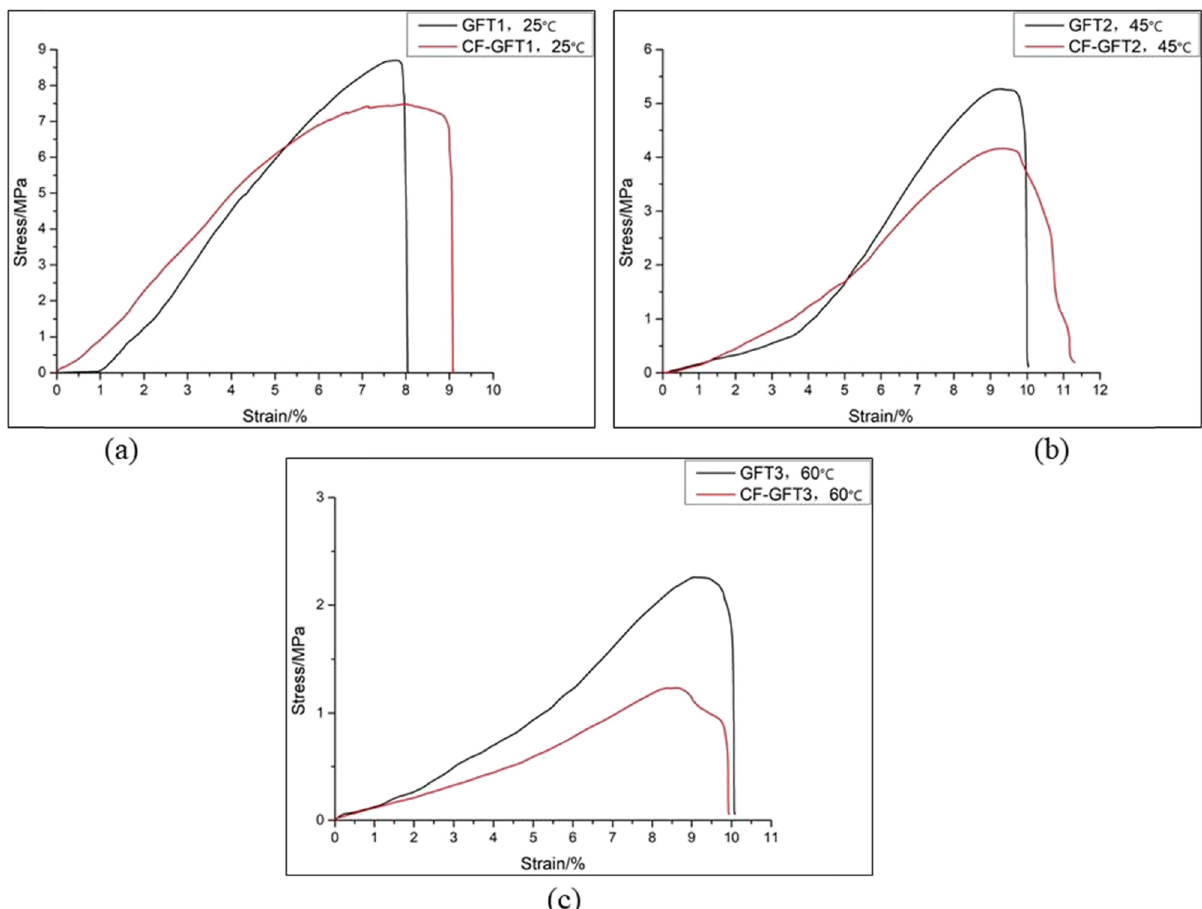
Figure 8: Stress – strain curves of two braided composites at the same temperature: ( a ) 25°C, ( b ) 45°C, and ( c )